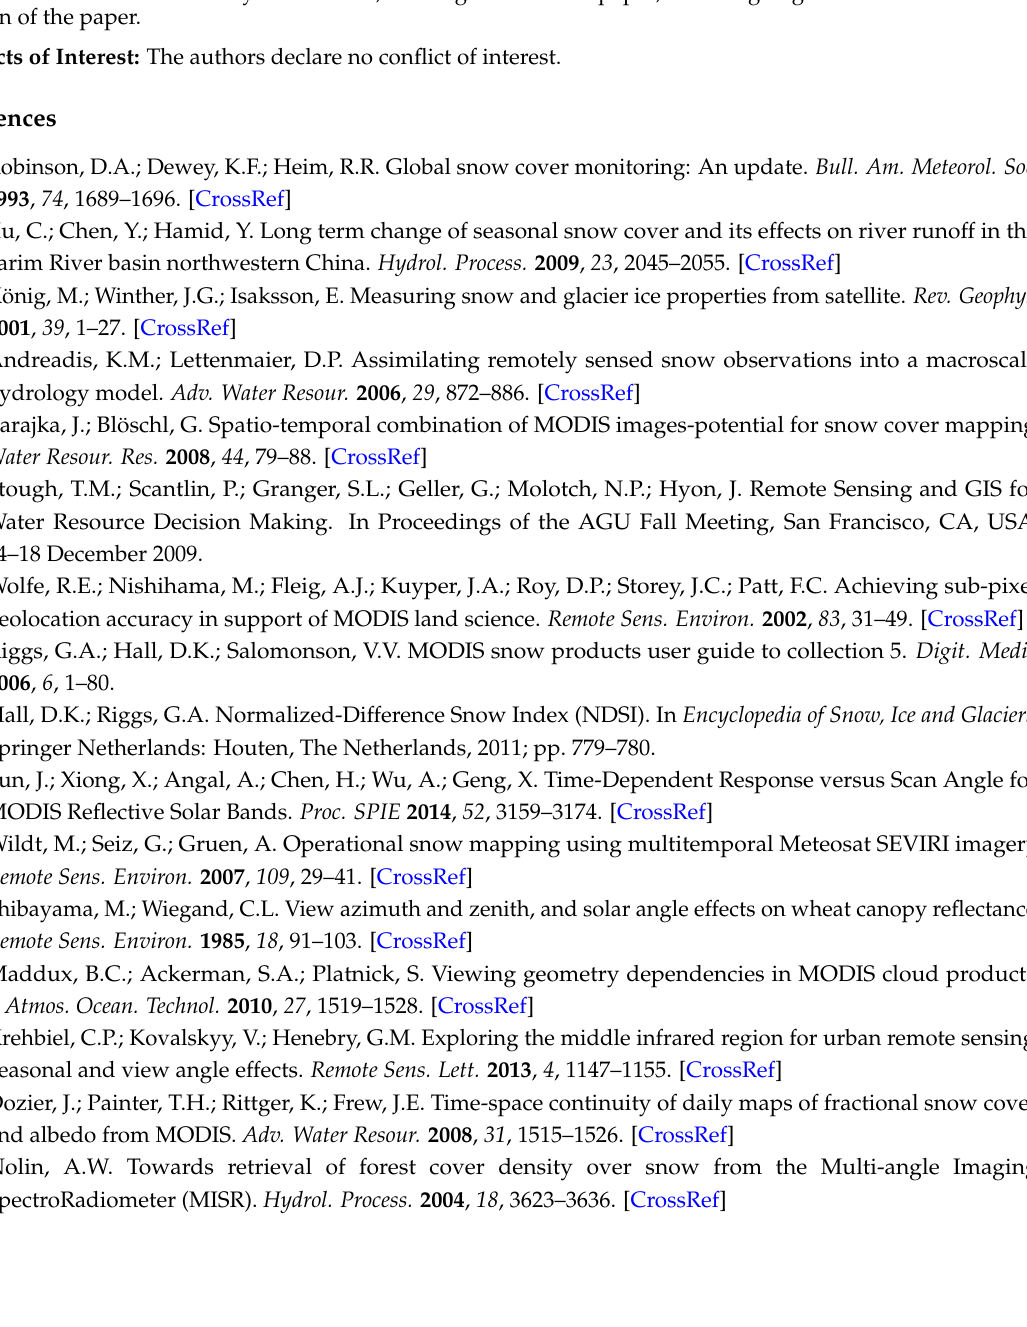
Table S1: Comparison of the overall accuracies between MOD10A1 and the modified snow cover product in 30 typical areas of Tarim river